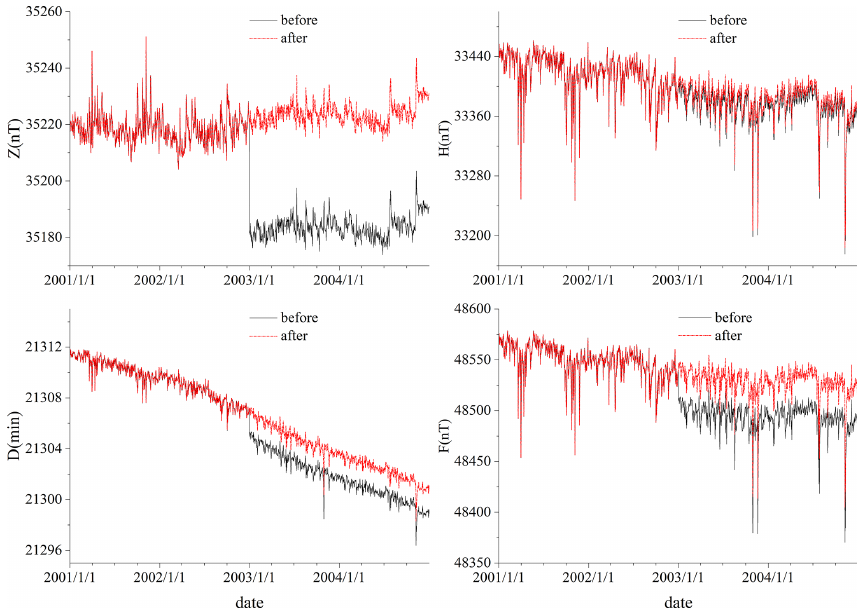
Figure 12. Plot of daily mean values before and after correction.